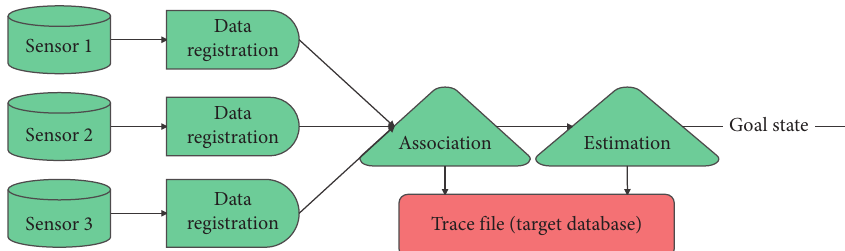
Figure 1: Block diagram of target state information fusion.